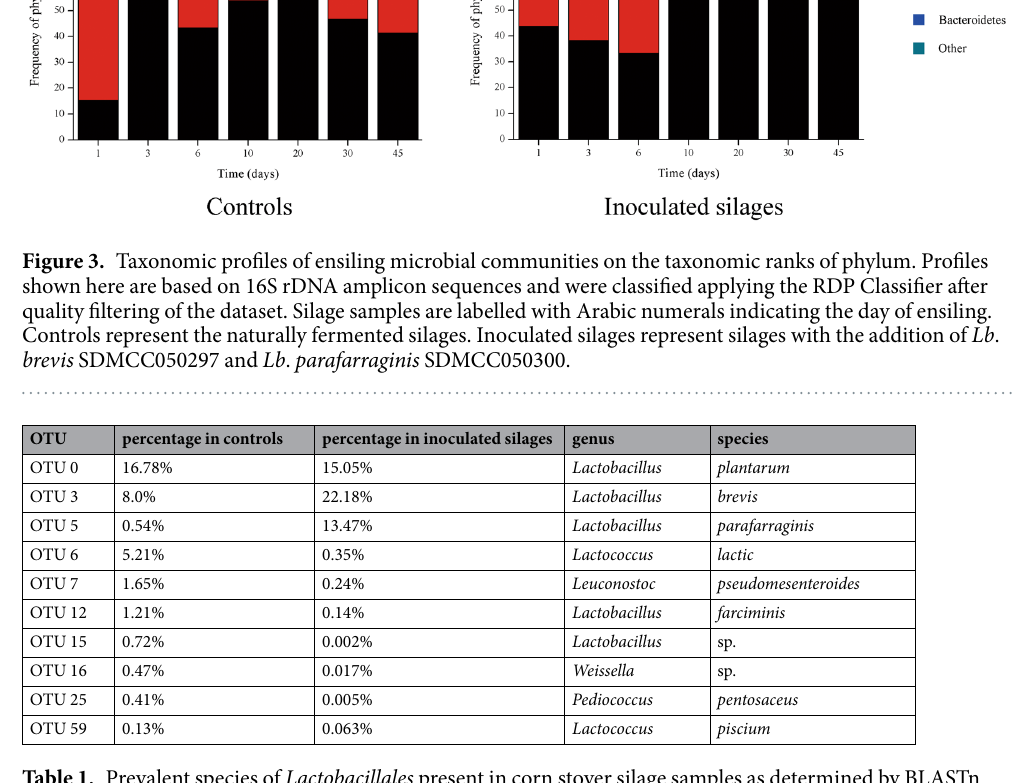
Table 1. Prevalent species of Lactobacillales present in corn stover silage samples as determined by BLASTn analyses of metagenomic sequences against sequences of whole genome sequences. OTU: operational taxonomic units; The percentage represents the average abundance of seven